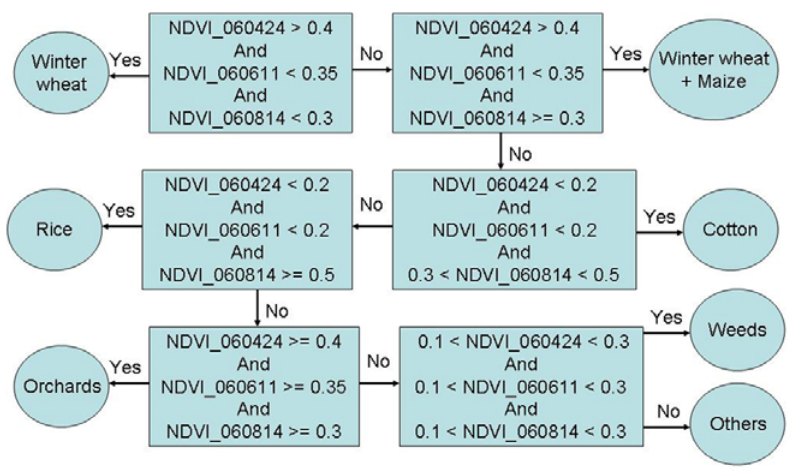
Figure 4. Decision rules for main crops classification.